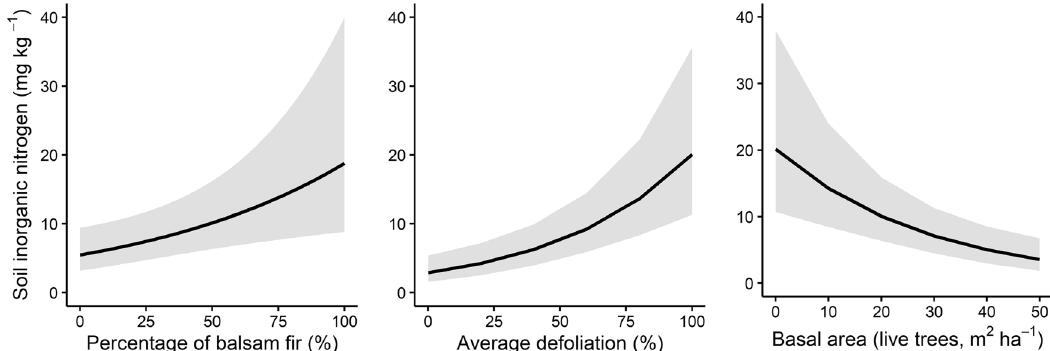
Fig. 6 Soil inorganic Nitrogen concentration with annual progression of the outbreak. Fitted relationships for soil inorganic nitrogen (SIN) concentration and proportion of balsam fi r, average tree defoliation and basal area, within a 5 m-radius. Shaded areas indicate 95% con fi dence intervals. The generalized linear mixed model was fi tted on 1548